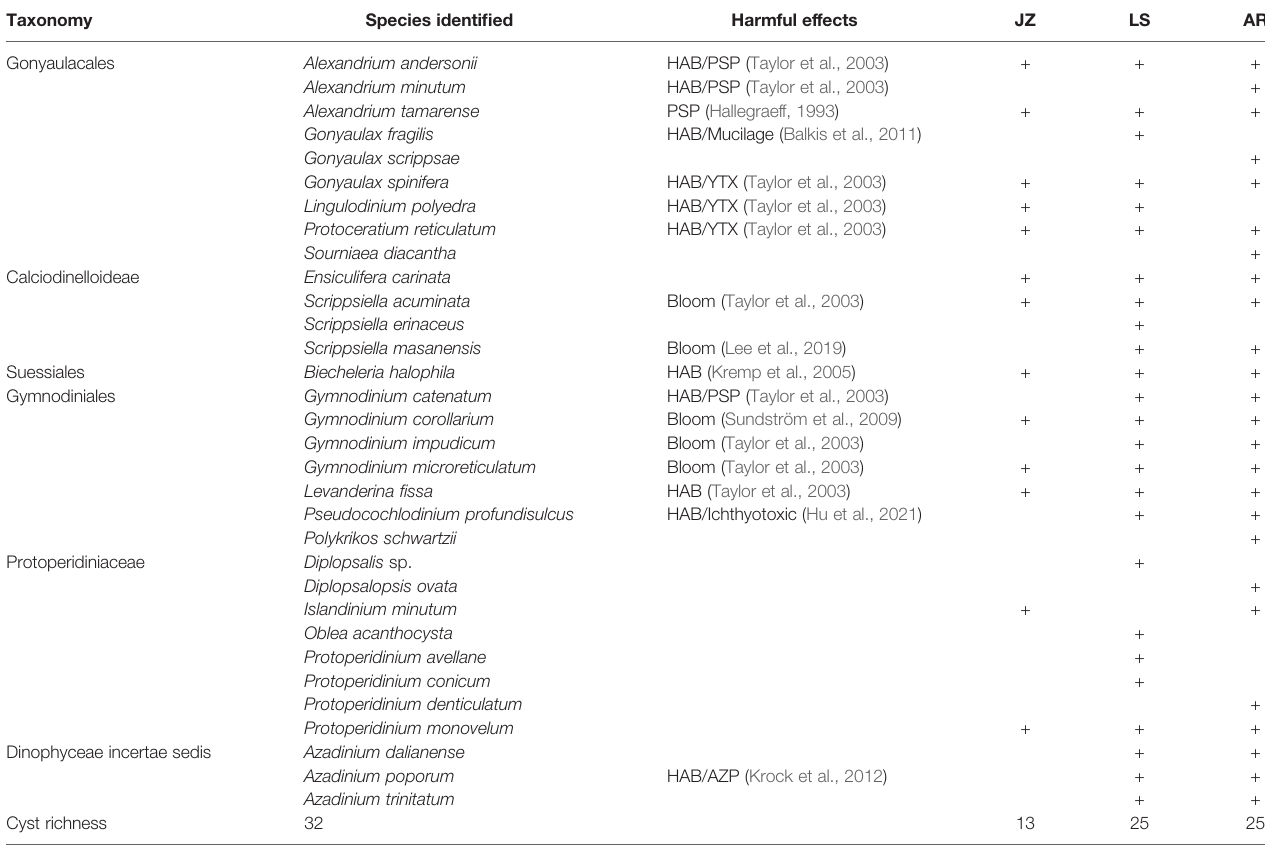
TABLE 1 | Information and distribution of dino fl agellate cysts in surface sediments from the Qingdao